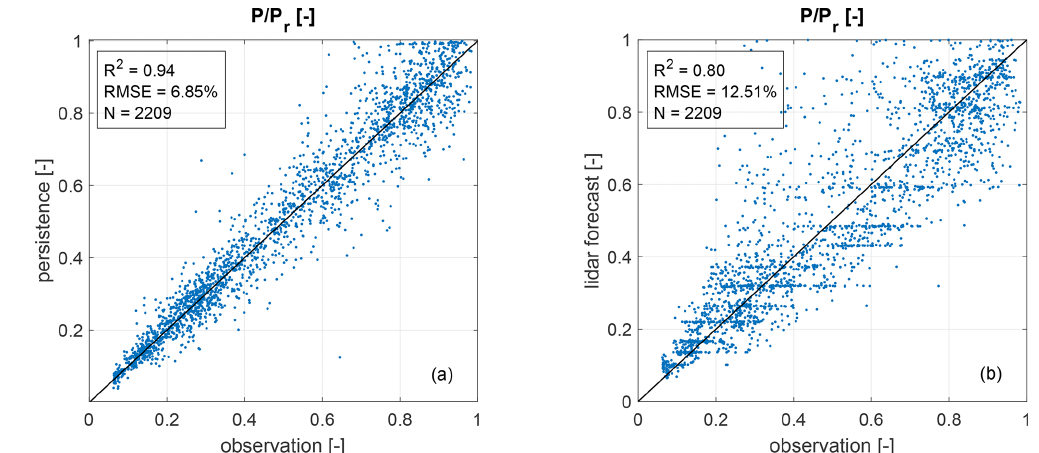
Figure 12. Comparison of 5min ahead power forecasts at turbine T3 with 1min mean SCADA data for (a) persistence and (b) the lidar-based forecast for stable and neutral stratification. Values are given as a fraction of the turbine’s nominal